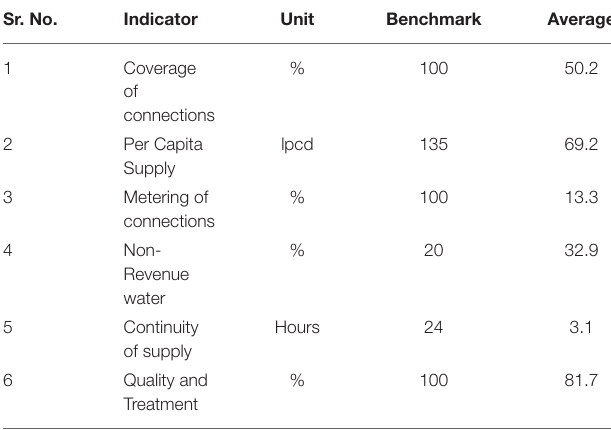
TABLE 1 | Service level benchmarks for water supply in India (MoUD, 2012). Sr.